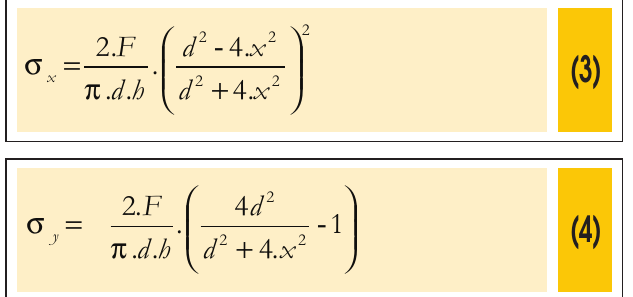
Figure 2 – Isostress fringes at disk under diametral compression (extracted from: Frocht